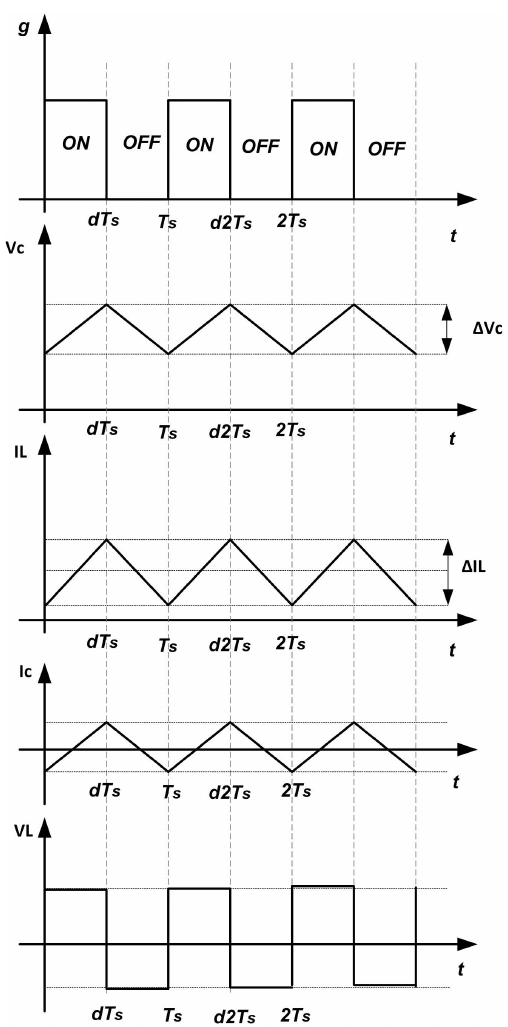
Figure 3. Waveforms of the DC-DC Buck converter when the system operates in continuous conduction mode (CCM)